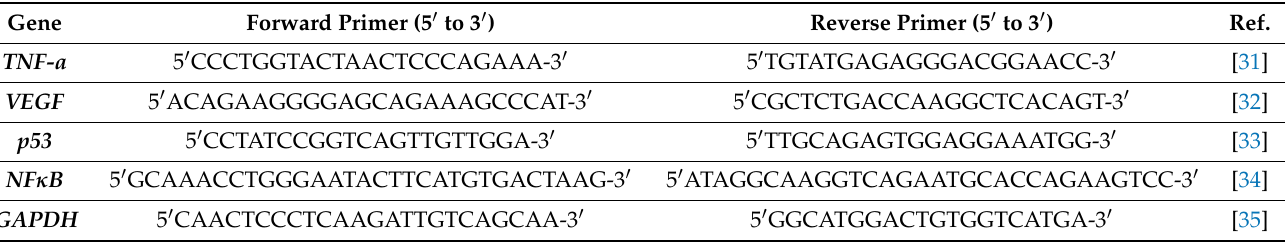
Table 1. Primer sequences used for reverse transcription polymerase chain reaction